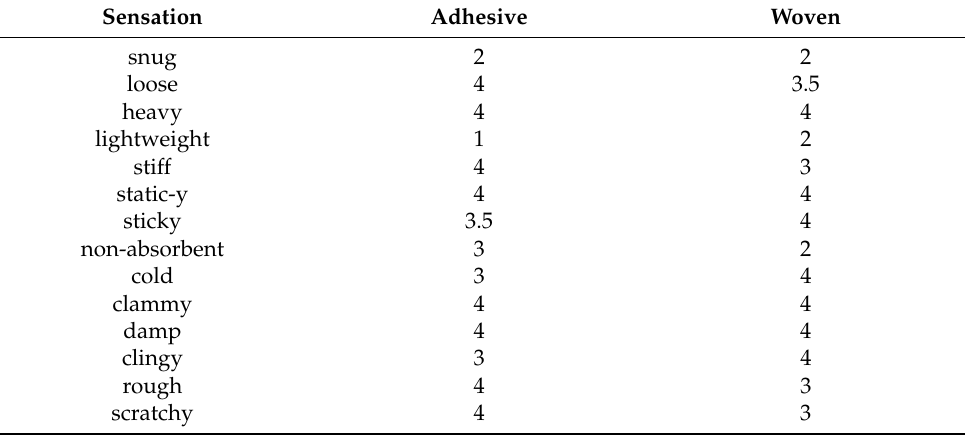
Table 1. Median comfort scores for each sensation with the adhesive and woven electrodes. Higher values indicate a low presence of the sensation, and lower values indicate a high presence of that sensation. Sensation Adhesive Woven snug 2 2 loose 4 3.5 heavy 4 4 lightweight 1